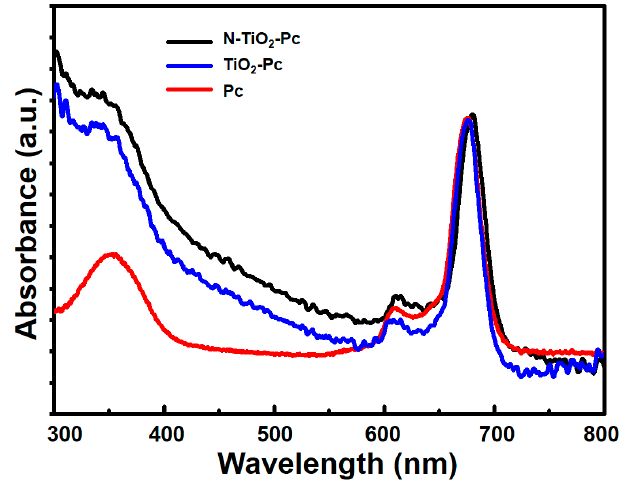
Figure 1. Absorption spectra of N-TiO 2 -Pc (black), TiO 2 -Pc (blue), and Pc (red) in aqueous